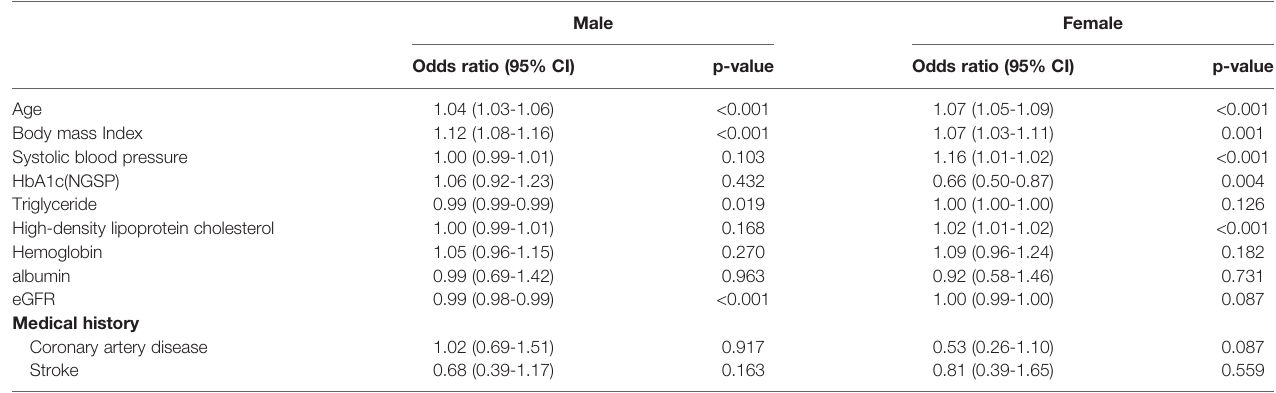
TABLE 3 | Logistic multivariable regression analysis for the combination of high adiponectin and high HOMA-R.